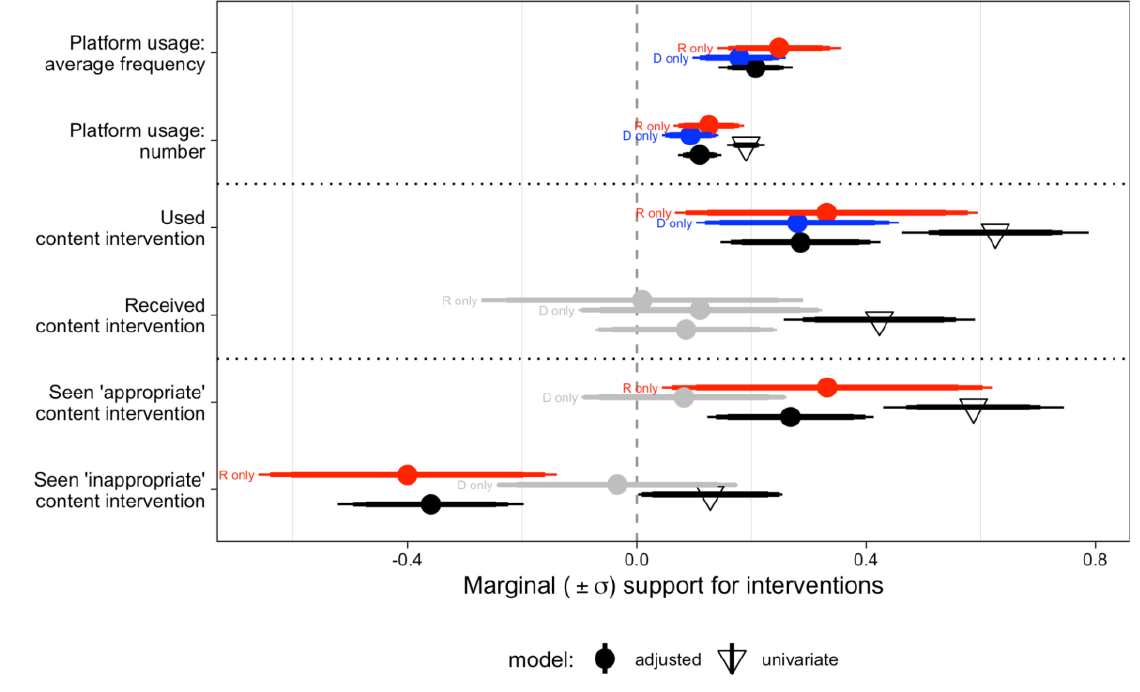
Figure 8. Association between social media experiences and intervention support (overall Index). This plot shows how a standardized increase in each experience variable ( y -axis) predicts an increase in the overall intervention support index ( x -axis) amongst all respondents (black), as well as Republicans only (red) and Democrats only (blue). See the Methods section for the control variables used in the adjusted